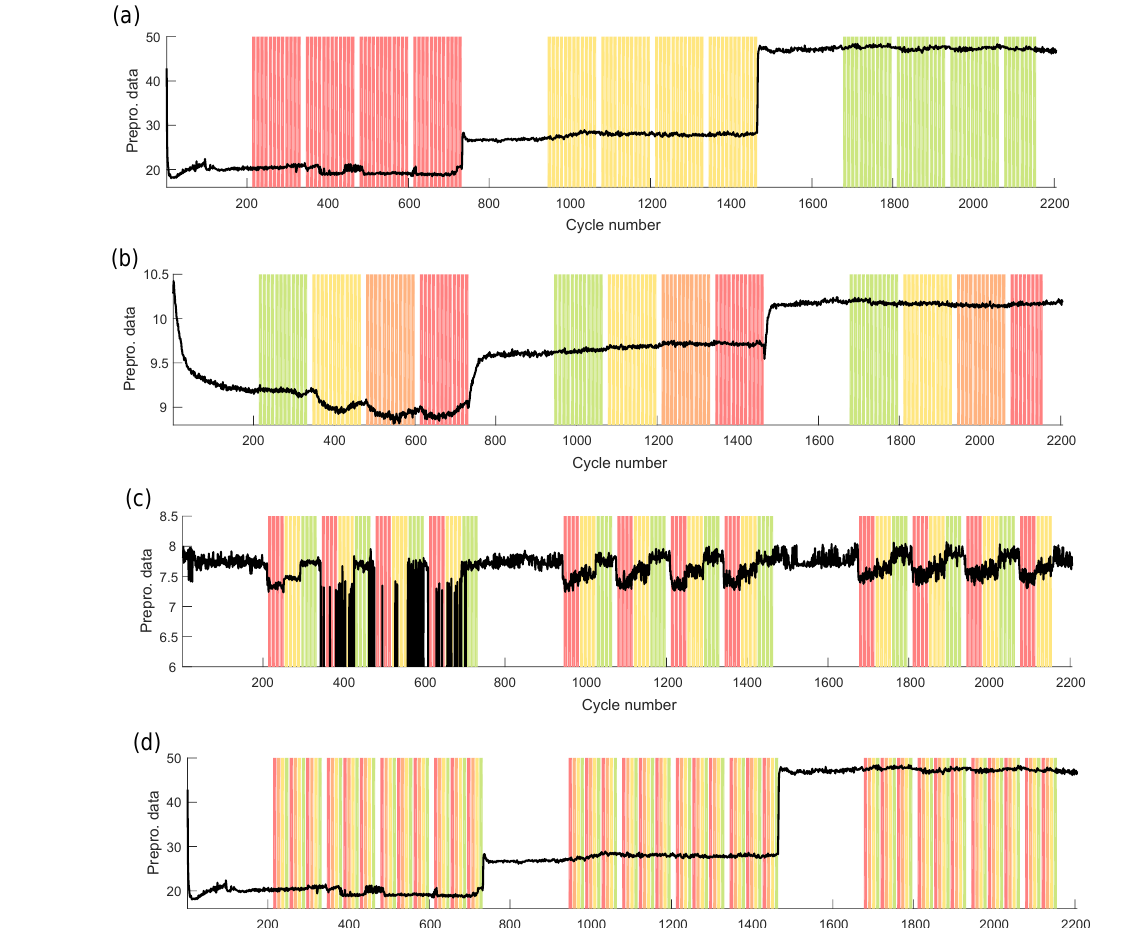
Figure 13. Graphical representation of four different grouping vectors to discriminate between the severity of four different faults. Panel (a) shows three different cooler faults and the resulting cooling efficiency as a signal, and in panel (b) , the pressure of the hydraulic accumu- lator is changed, which can be observed, e.g., in a flow sensor signal. Panel (c) shows several grades of pump leakage, evident in a different flow sensor. In (d) , different grades of valve faults were experimentally simulated, which cannot be observed directly in any one individual sensor